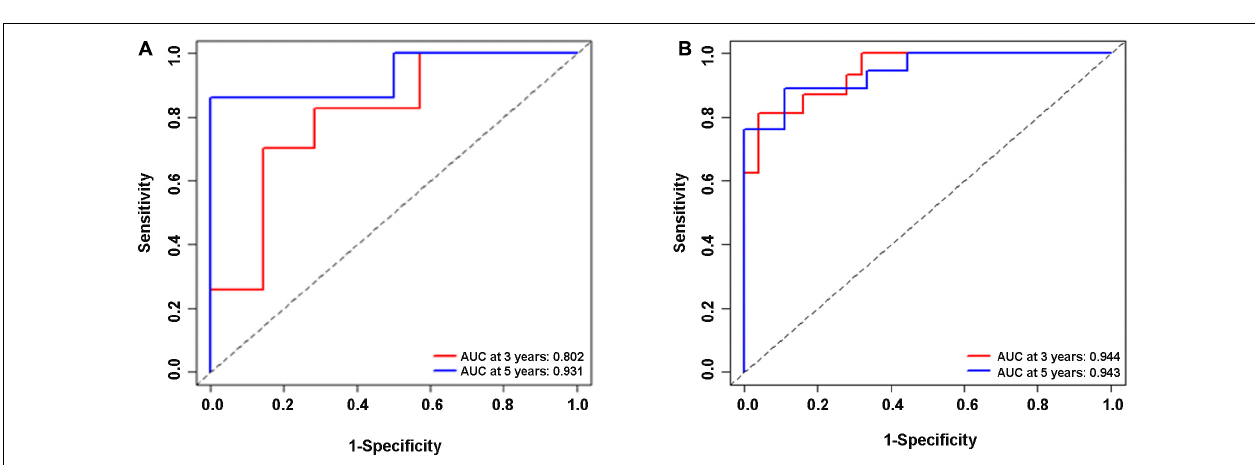
FIGURE 5 | The distribution of risk score and survival status of the nine-gene signature in the validation cohort (A) and entire cohort. (B) Kaplan-Meier curves of overall survival in the validation cohort (C) and entire cohort (D) .